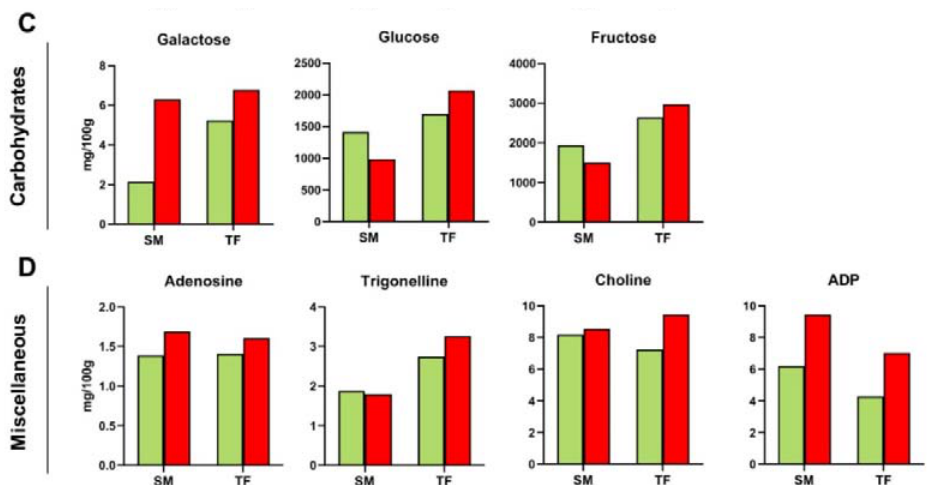
Figure 2. Histograms relative to metabolites identified by H 1 -NMR spectroscopy in tomato hydroalcoholic extracts from pink (green) and red (red) SM and TF cultivars: ( A ) Amino acids; ( B ) Organic acids; ( C ) Carbohydrates; ( D ) Other compounds. Data are expressed as mg / 100 g